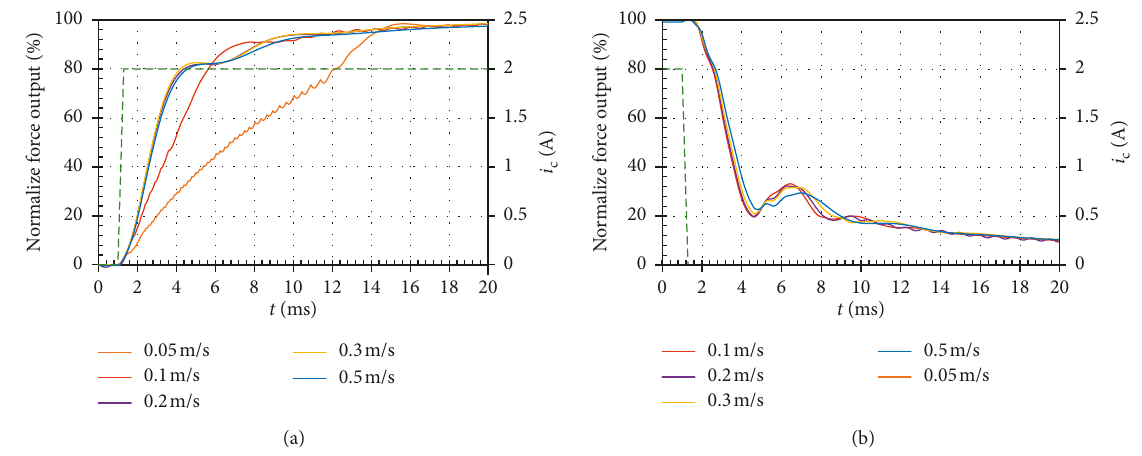
Figure 30: Influence of piston velocity for control current rise and drop (green dashed line) on the force output (full line). (a) Current rise. (b) Current drop.